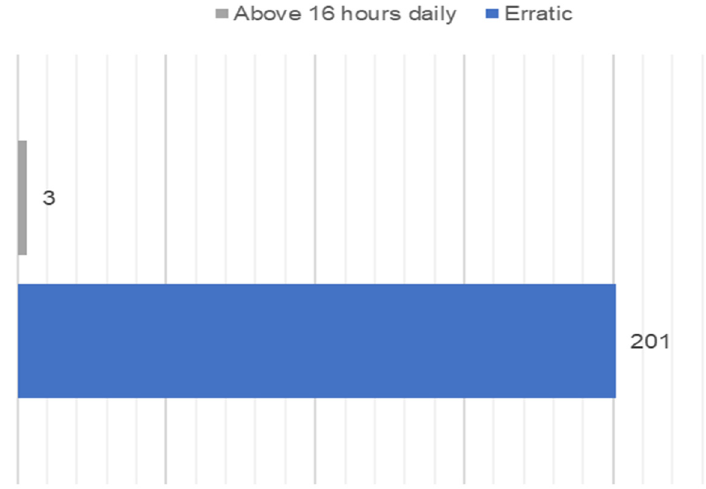
Figure 8. Households’ access to varying times of electricity. Source: Fieldwork.